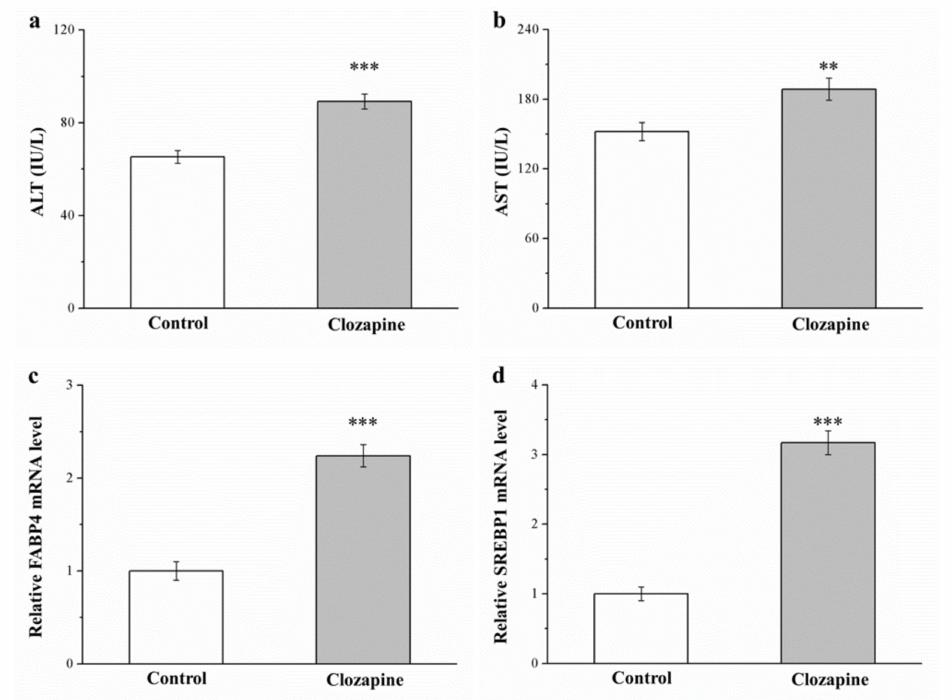
Figure 4. Serum ( a ) alanine aminotransferase (ALT) and ( b ) aspartate aminotransferase (AST) levels and ( c ) FABP4 and ( d ) SREBP1 mRNA levels in livers derived from clozapine and control groups after 8-week experimental period. Data are mean ± standard deviation ( n = 10). ** p < 0.01, *** p <